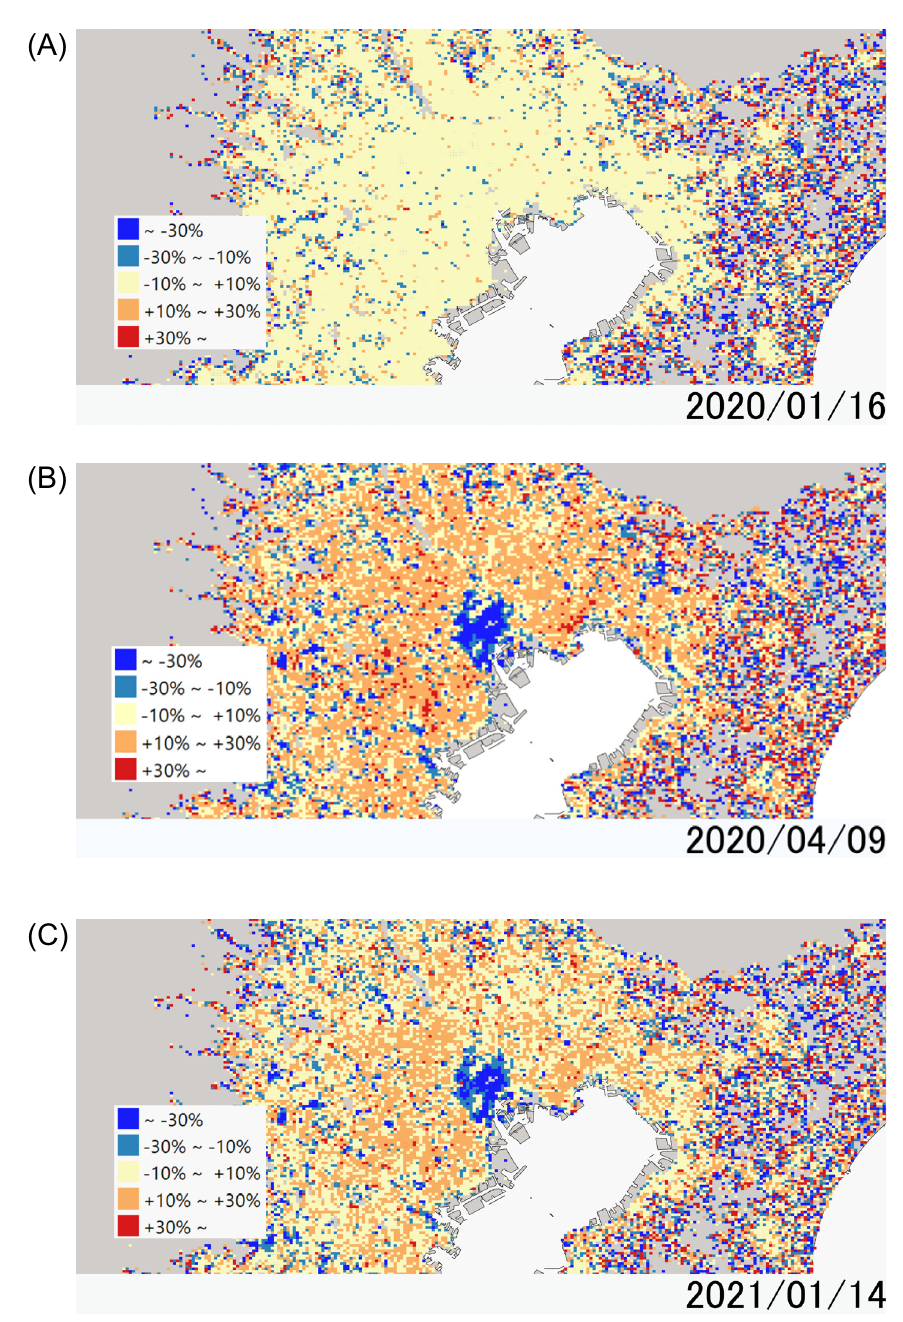
Fig 6. Population density in Tokyo MA in comparison to before COVID-19: (A)Before COVID-19; (B)First lockdown; (C) Second lockdown. We obtained Figs 6A, 6B, and 6C from Natural Earth and National Land Information Division, National Spatial Planning and Regional Policy Bureau, Ministry of Land, Infrastructure, Transport and Tourism of Japan. X is the vector of the independent variables as follows: First, we used the relative(i.e. per- ij , t population) number of infection cases from one week ago ( IFC ) in the destination prefecture to show infection risk by trip. The motivation of considering the relative infection cases is to control the difference in population sizes among prefectures for evaluating substantial